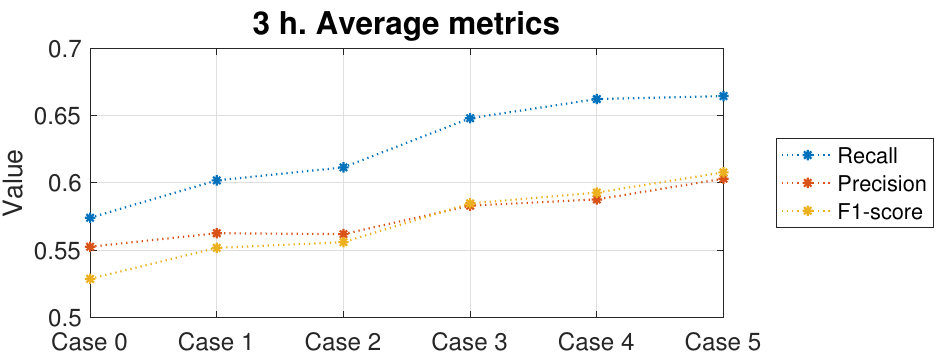
Figure 18. Average metrics of all the classification methods considering the 6 different scenarios assessed, for a time prediction horizon of +3 h.